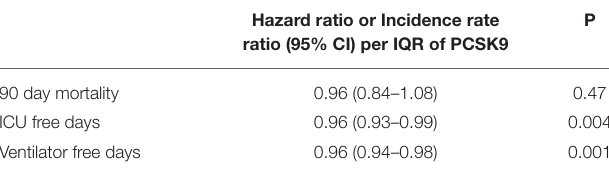
TABLE 4 | Cox model adjusted for age, sex, trial and severity of critical illness. Models of the association of PCSK9 level with the secondary outcomes of ICU free and ventilator free